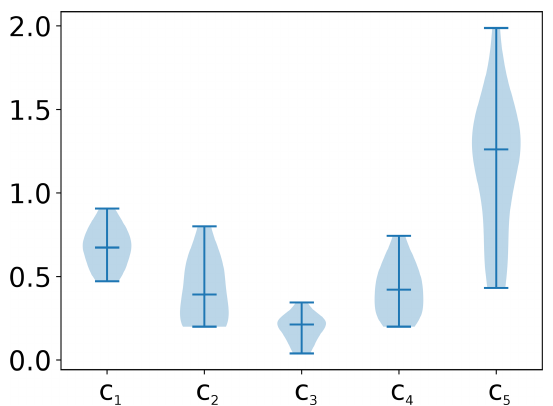
Figure A3. Distribution of time lags obtained after fitting the test model to the Fluxnet sites. Shown here are the distributions used for generation of heteroscedastic time series.